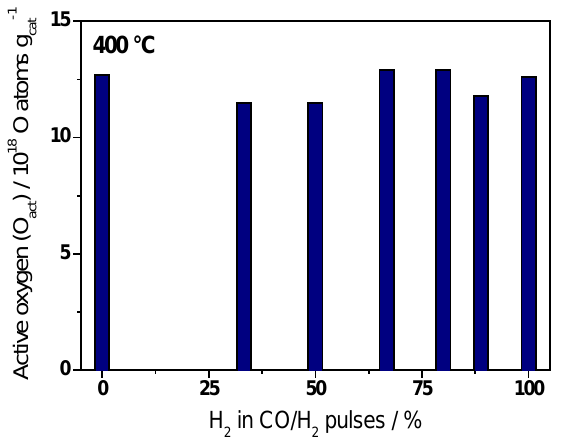
Figure 3. Absolute amounts of active oxygen (O act ) removal from a fully oxidized Au/TiO 2 catalyst (after O 2 /Ar pulses) by CO and/or H 2 during CO, H 2 , and CO/H 2 pulses with varying ratios of H 2 (33%–89% H 2 ) at 400 °C.